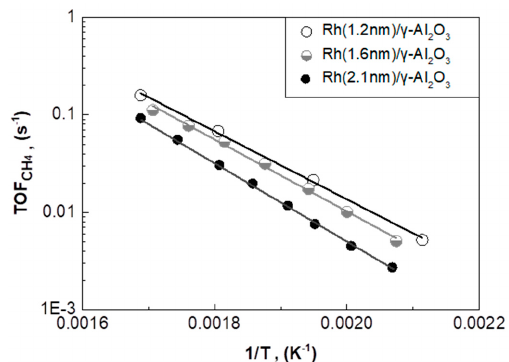
Figure 6. Arrhenius plots of the CH 4 formation turnover frequency ( TOF CH4 ) obtained for Rh / γ -Al 2 O 3 catalysts with different mean Rh particle size. Experimental conditions as in Figure 5.